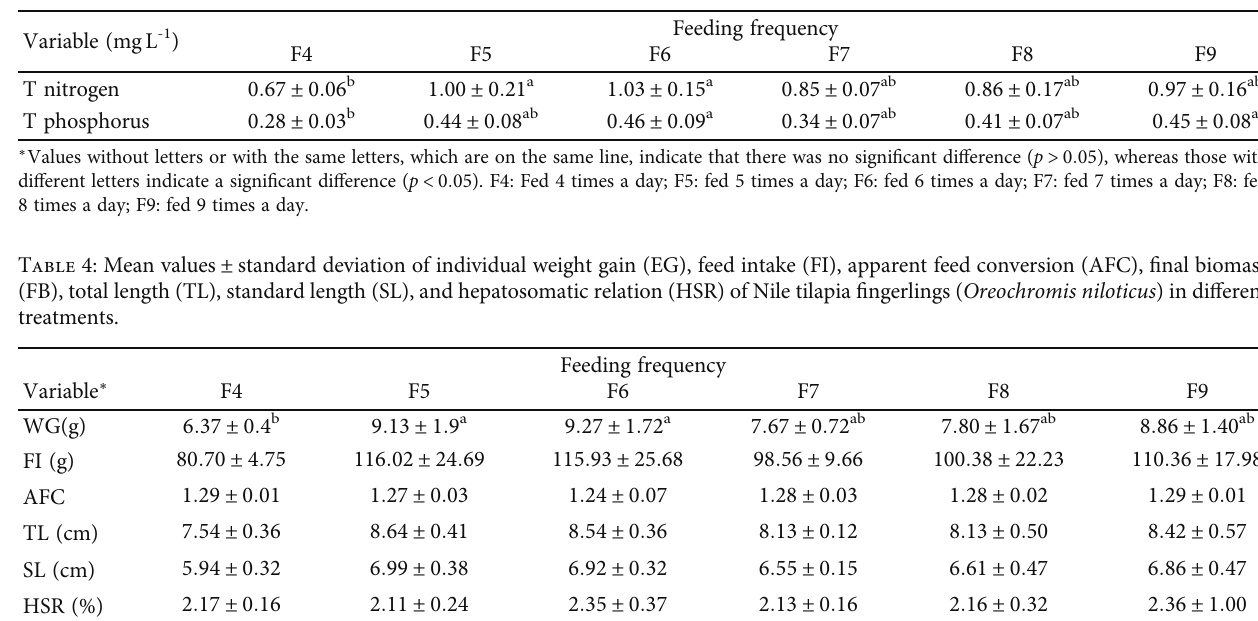
Table 3: Total nitrogen (TN) and total phosphorus (TP) in water during the experimental period with Nile tilapia ( Oreochromis niloticus ). Variable (mgL -1 )